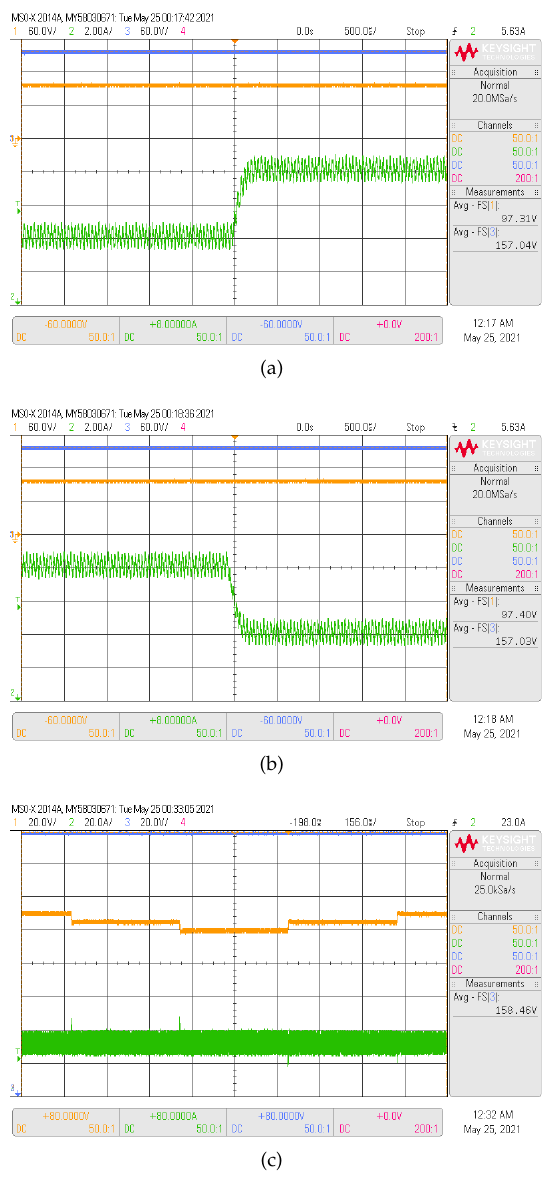
Figure 4. Experimental ( a , b ), responses of the sliding digital current input control when the reference i ref : ( a ) changes from 4 A to 8 A, and ( b ) from 8 A to 4 A. The converter operates with V g = 100 V and V o = 160 V of input and output voltage, respectively. CH1: V g (60 V/div), CH2: V o (60 V/div), CH3: i L (2 A/div) and a time base of 500 µ s. ( c ) responses of the double-loop using sliding digital current control when the reference v ref changes with steps of 5 V between 100 V to 110 V while the output voltage ( V o = 160 V) ensures a boost operation. CH1: v g (20 V/div), CH2: V o 20 V/div), CH3: i L (20 A/div) and a time base of 156